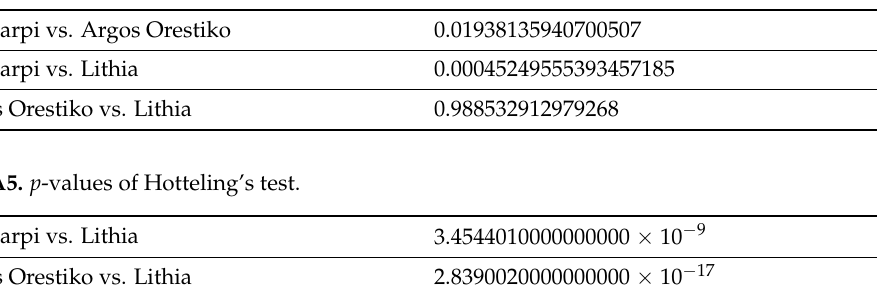
Table A4. p -values of Bartlett’s test.